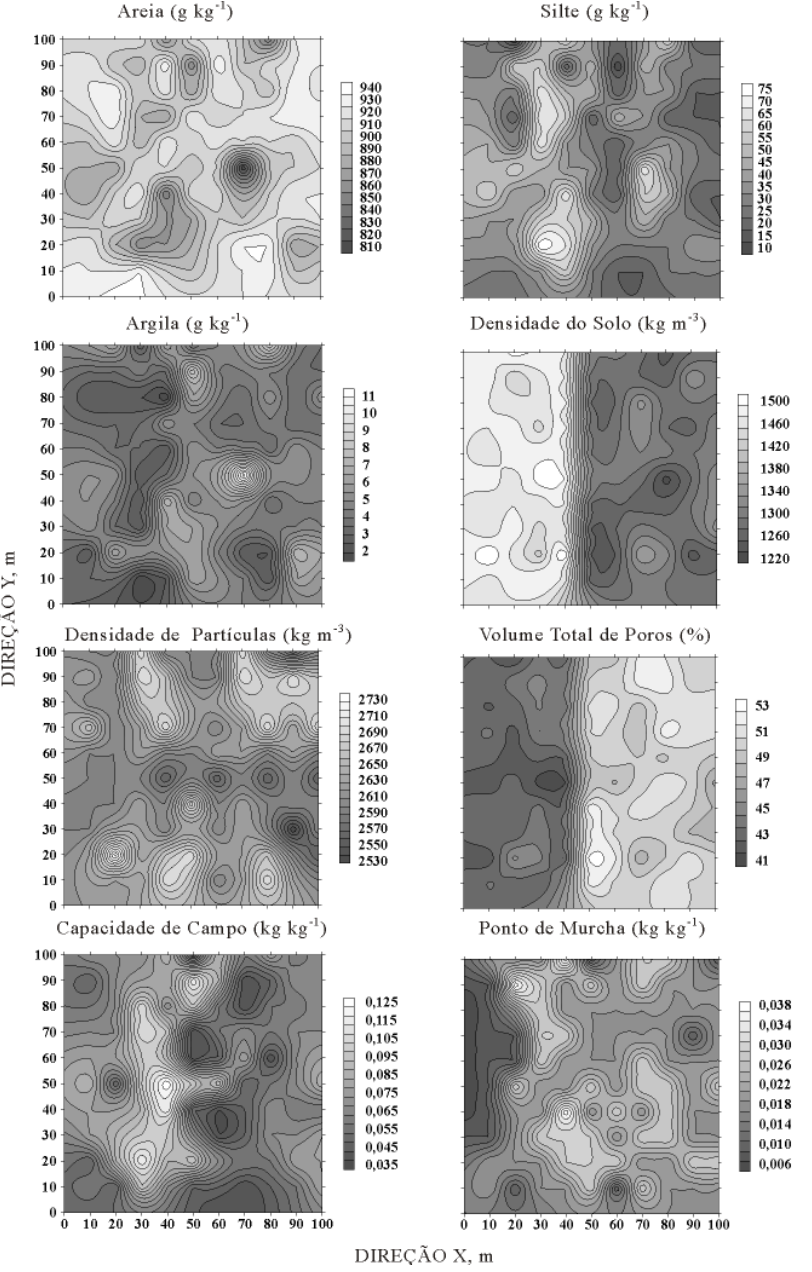
Figura 2. Distribuição espacial das variáveis estudadas no